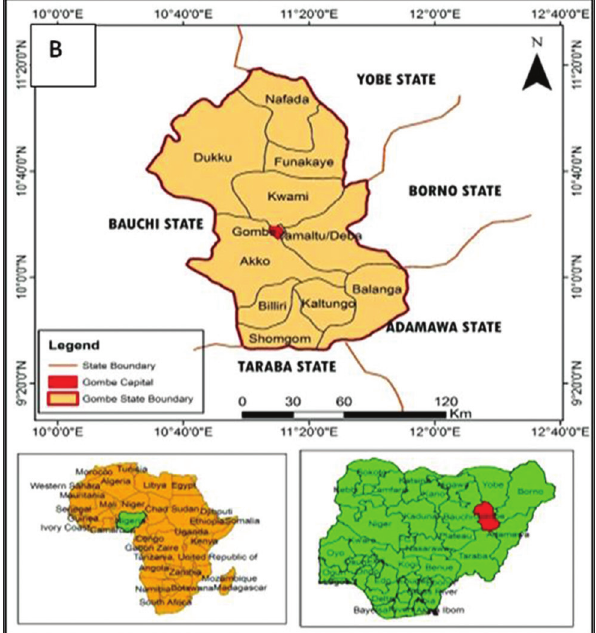
Figure-1: Map of Gombe State showing the study